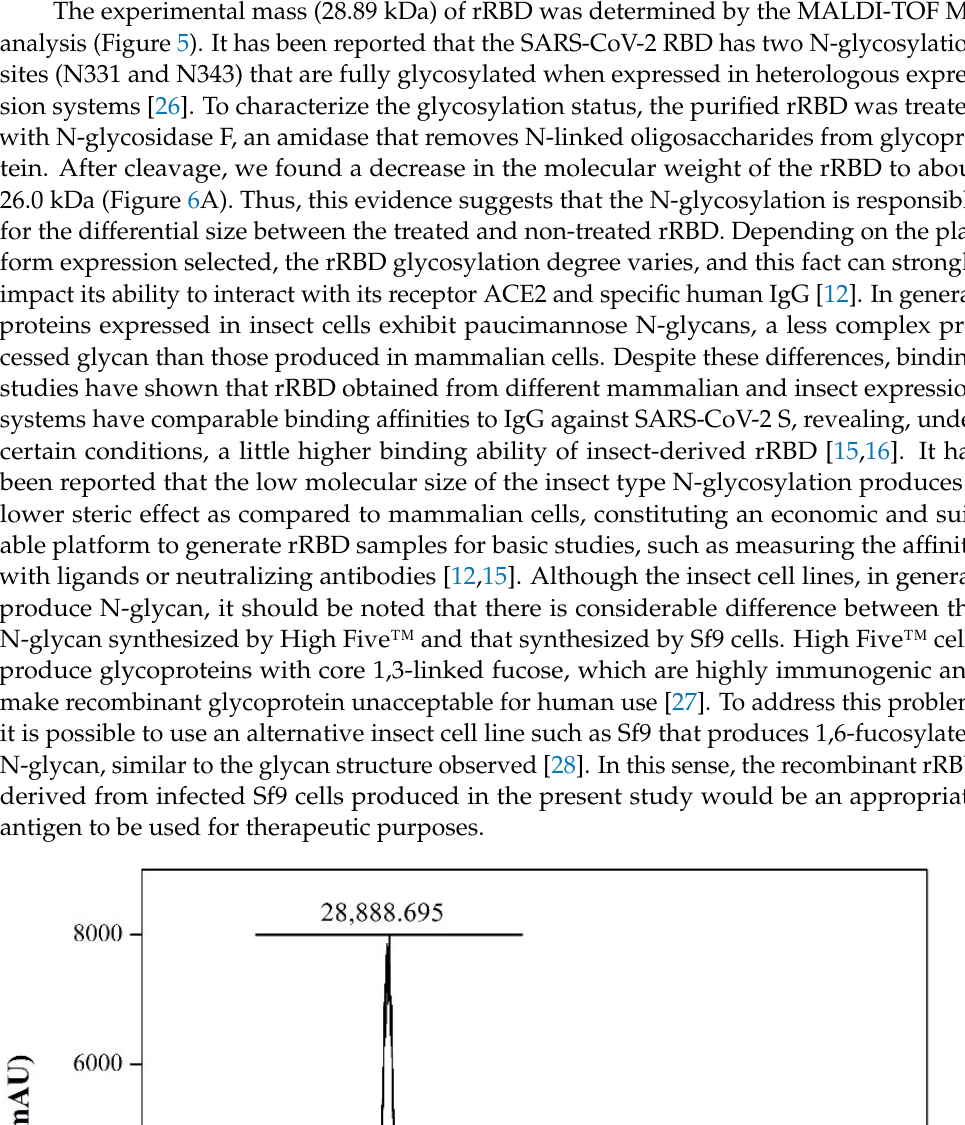
Figure 6. Characterization of purified rRBD. ( A ) rRBD glycosylation analysis. N-glycosidase F-me- diated in-vitro deglycosylation of purified rRBD. Western blot in reducing condition developed with anti-S antibody. ( B ) Analysis of purified rRBD by SDS-PAGE in non-reducing condition. Lanes: M, protein marker; rRBD, purified rRBD; rRBD + PNGase. F, purified rRBD treated with N-glyco- sidase F. Furthermore, RBD has a total of 9 cysteine residues, eight of which form four pairs of disulfide bonds and unpaired residue (Cys538) close to the C-terminus responsible for the formation of oligomeric aggregate [15,29]. In addition, several hydrophobic patches have been identified on the surface of RBD that could promote noncovalent multimeriza- tion [30]. The analysis of purified rRBD by SDS-PAGE (Figure 6B) in the non-reducing condition showed the formation of a constant fraction of dimeric species, confirming what we had previously detected in the expression supernatant (Figure 2D). In addition, we evaluated the purified rRBD oligomeric state produced in our process by SEC (Figure 7A). The rRBD eluted as the main peak with an elution volume close to 33.3 mL and a minor one at 30.6 mL. The sample is homogeneous and mainly monomeric containing a low pro- portion (17%) of the dimer form, confirming what we had previously observed in the ex- pression supernatant (Figure 2D). The purity of the monomeric RBD, after the SEC step,